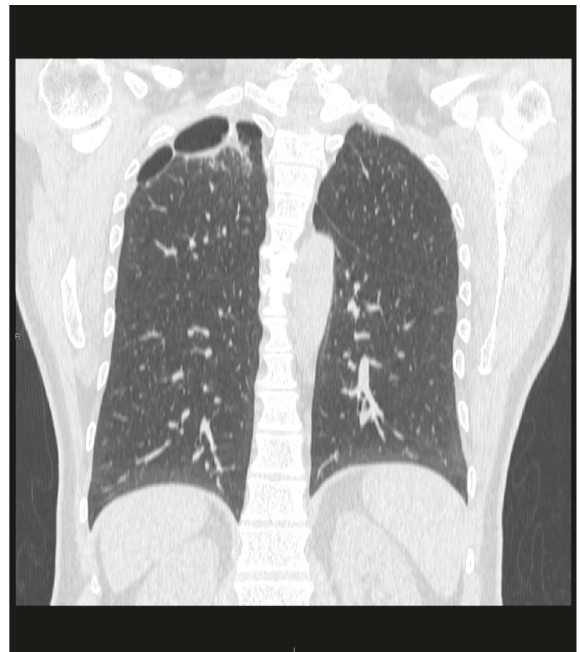
Figure 2: Chest CT demonstrating apical